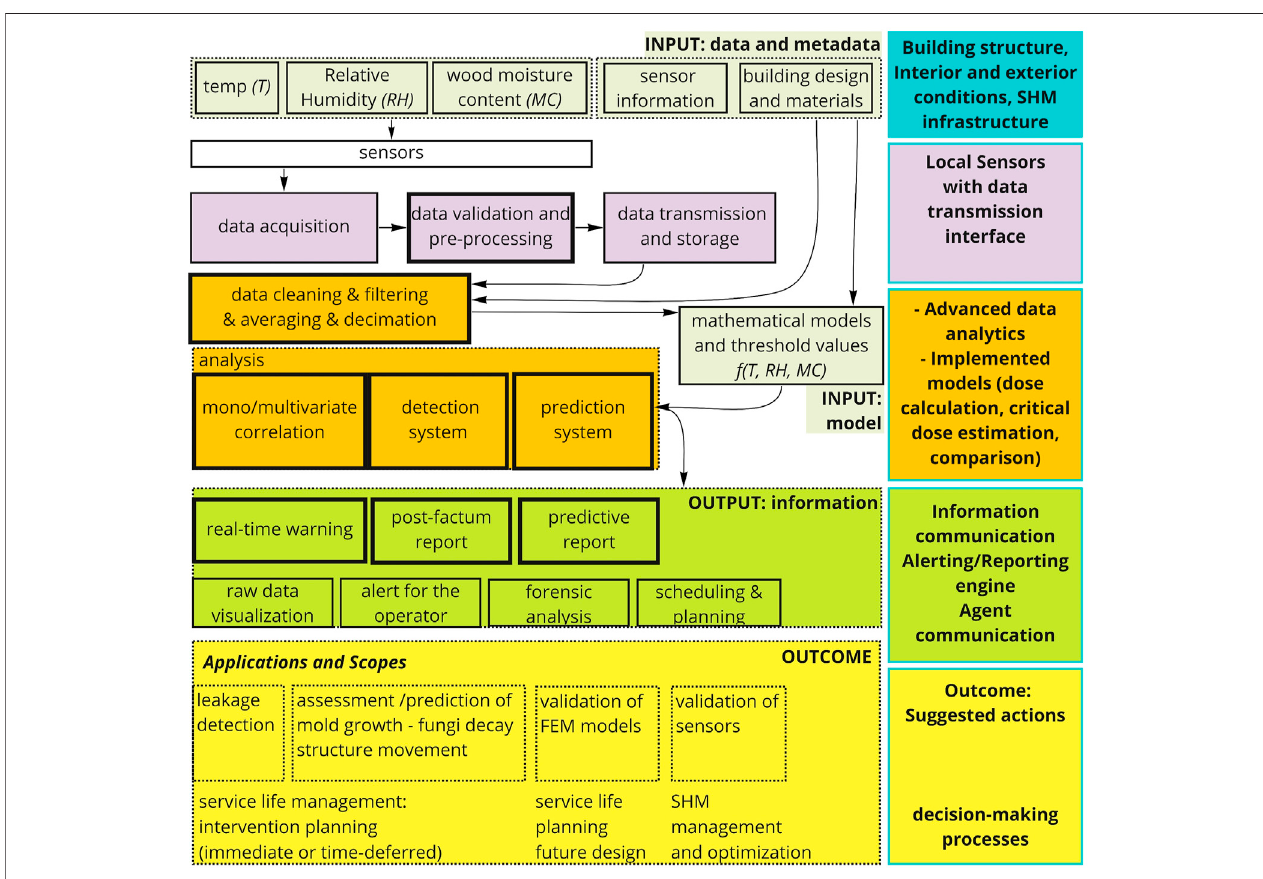
FIGURE 1 | Functional schema for implementation of hygrothermal monitoring tasks with the avatar approach.